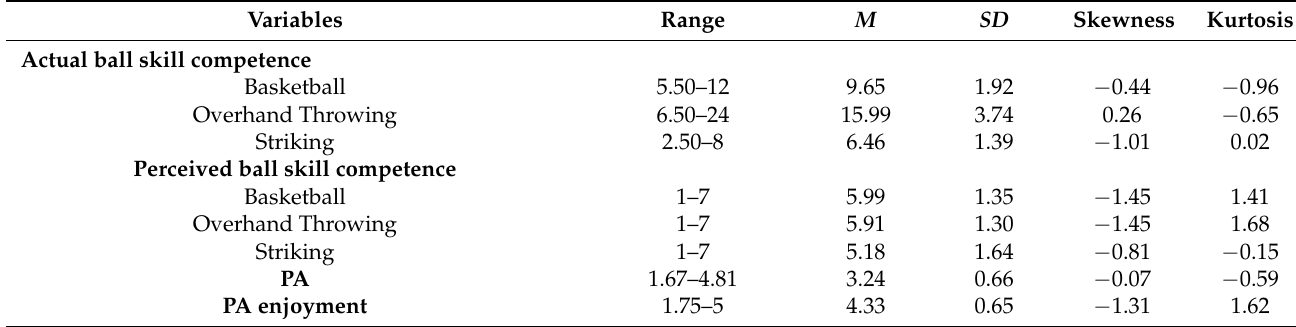
Table 1. Descriptive statistics of study variables (N =